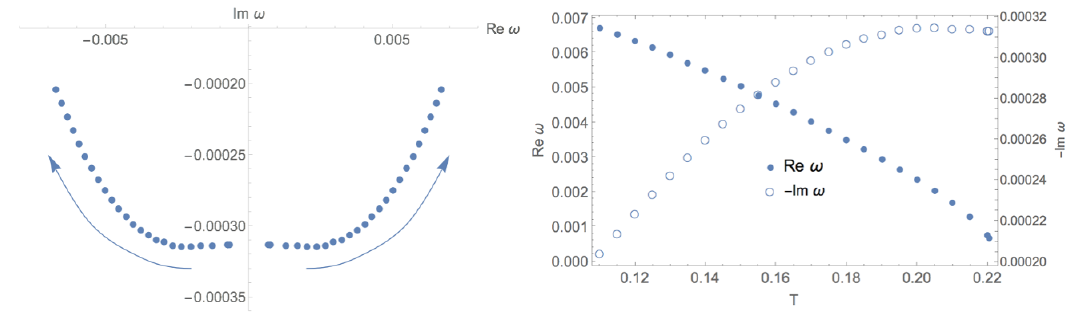
Figure 8 . First QNM for the pinned spontaneous case (2.11) with varying temperature. The left panel shows the motion of the QNM in the complex plane, the arrow pointing towards lower temperatures as T=T c changes from 1 to 0.63, same range as (cid:12)gure 7. The right panel shows both real and imaginary parts as a function of temperature, with the corresponding scales given on the left and right vertical axes. As the temperature is lowered, the QNM comes closer to the real axis and the coherent contribution to the transport never